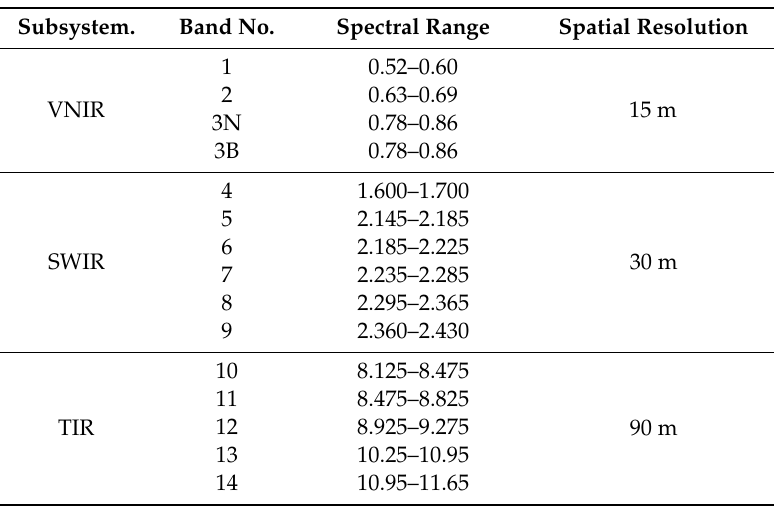
Table 1. Spectral ranges and spatial resolutions of the Advanced Spaceborne Thermal Emission and Reflection Radiometer (ASTER) spectral